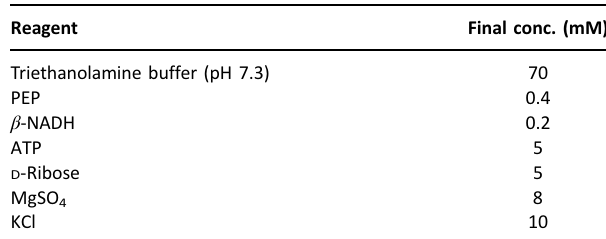
Table 6. Reagents for RK